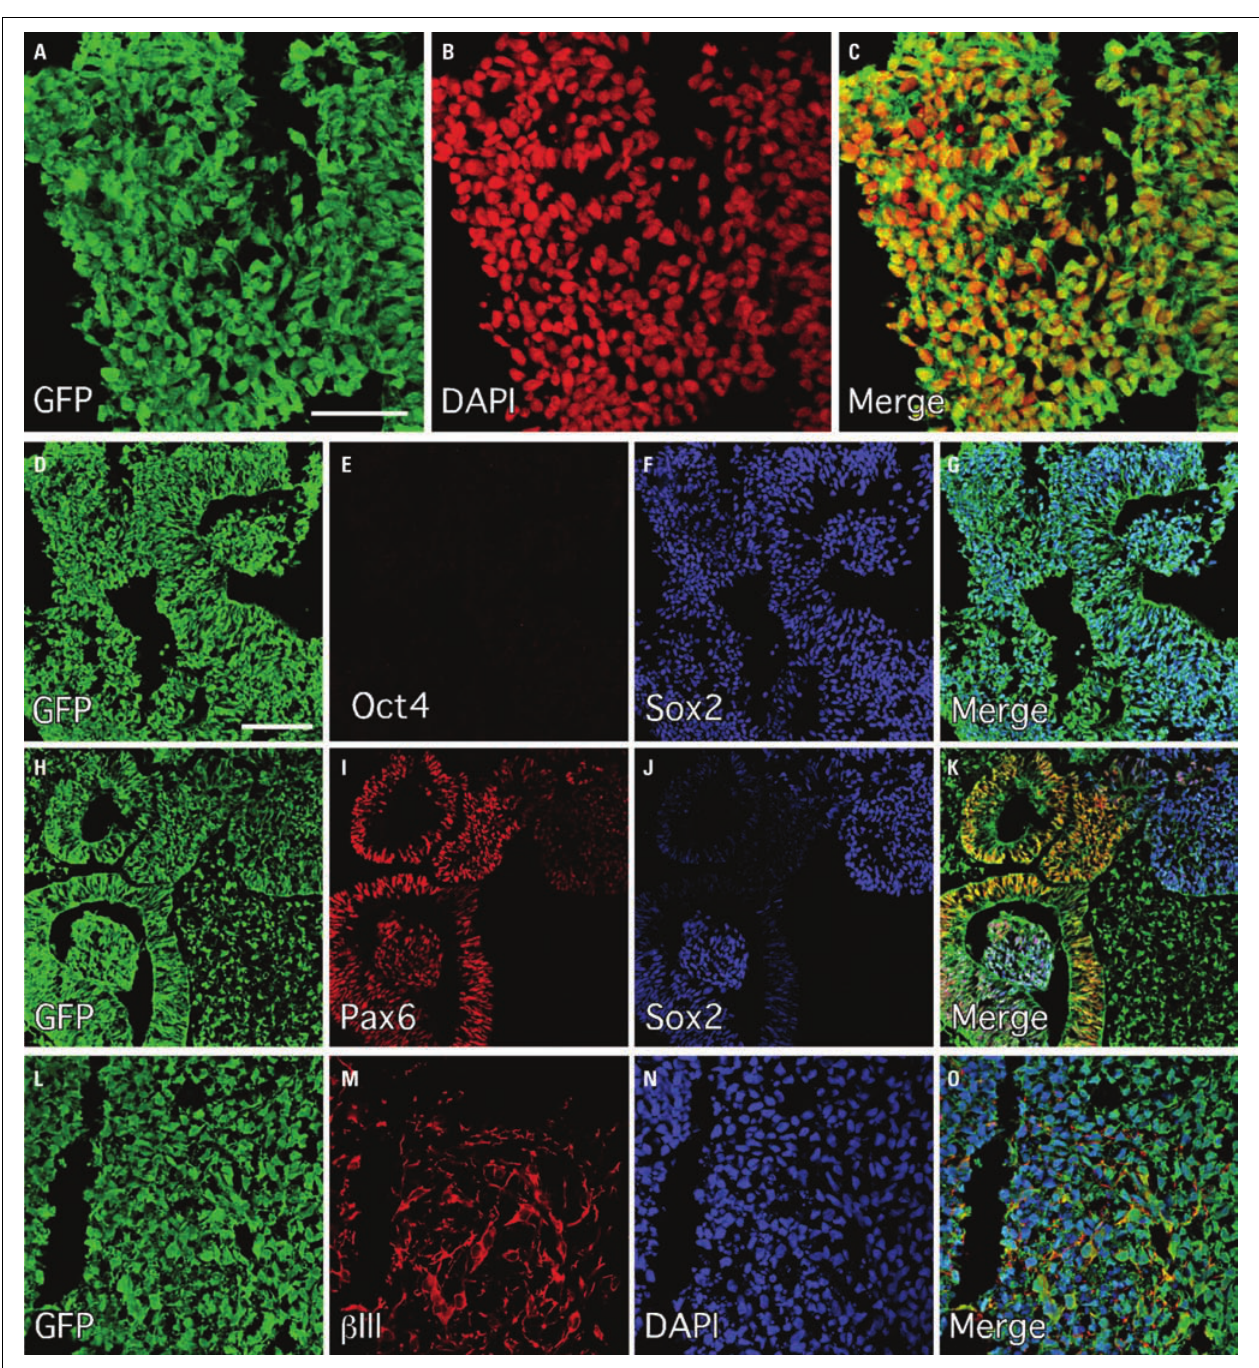
also widely expressed throughout the cultures and largely overlapped with Sox2 expression domains including prominent expression in neural rosette structures. (L–O) These panels are show a region in the periphery of the differentiating neurospheres where β III-tubulin (red) was expressed in cells with neuronal morphology. Scale bars: (A–C) 50 μ m, (D–O) 100 μ m.